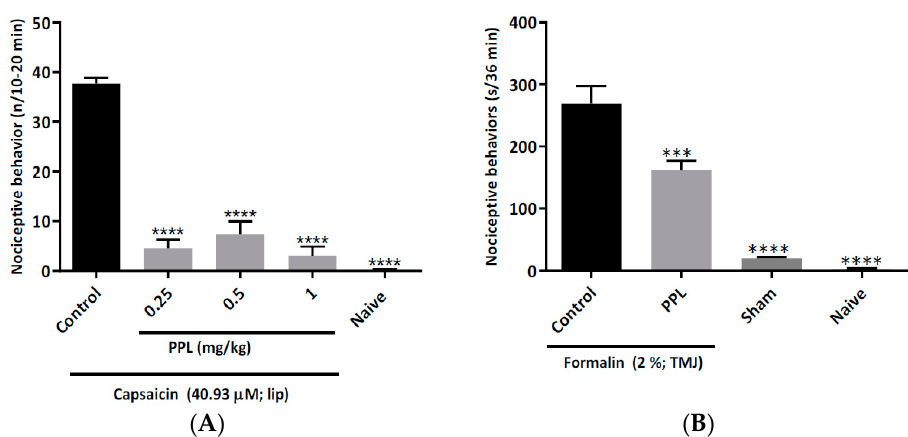
Figure 4. Effect of PPL on capsaicin-induced orofacial nociception in mice ( A ) and on formalin- induced temporomandibular junction nociception in rats ( B ). The results are expressed as mean values ± standard error of the number of nociceptive behaviours for each group. ANOVA followed by Tukey test. *** p < 0.01 and **** p < 0.0001 vs Control. PPL = 0.25 mg/kg PPL.